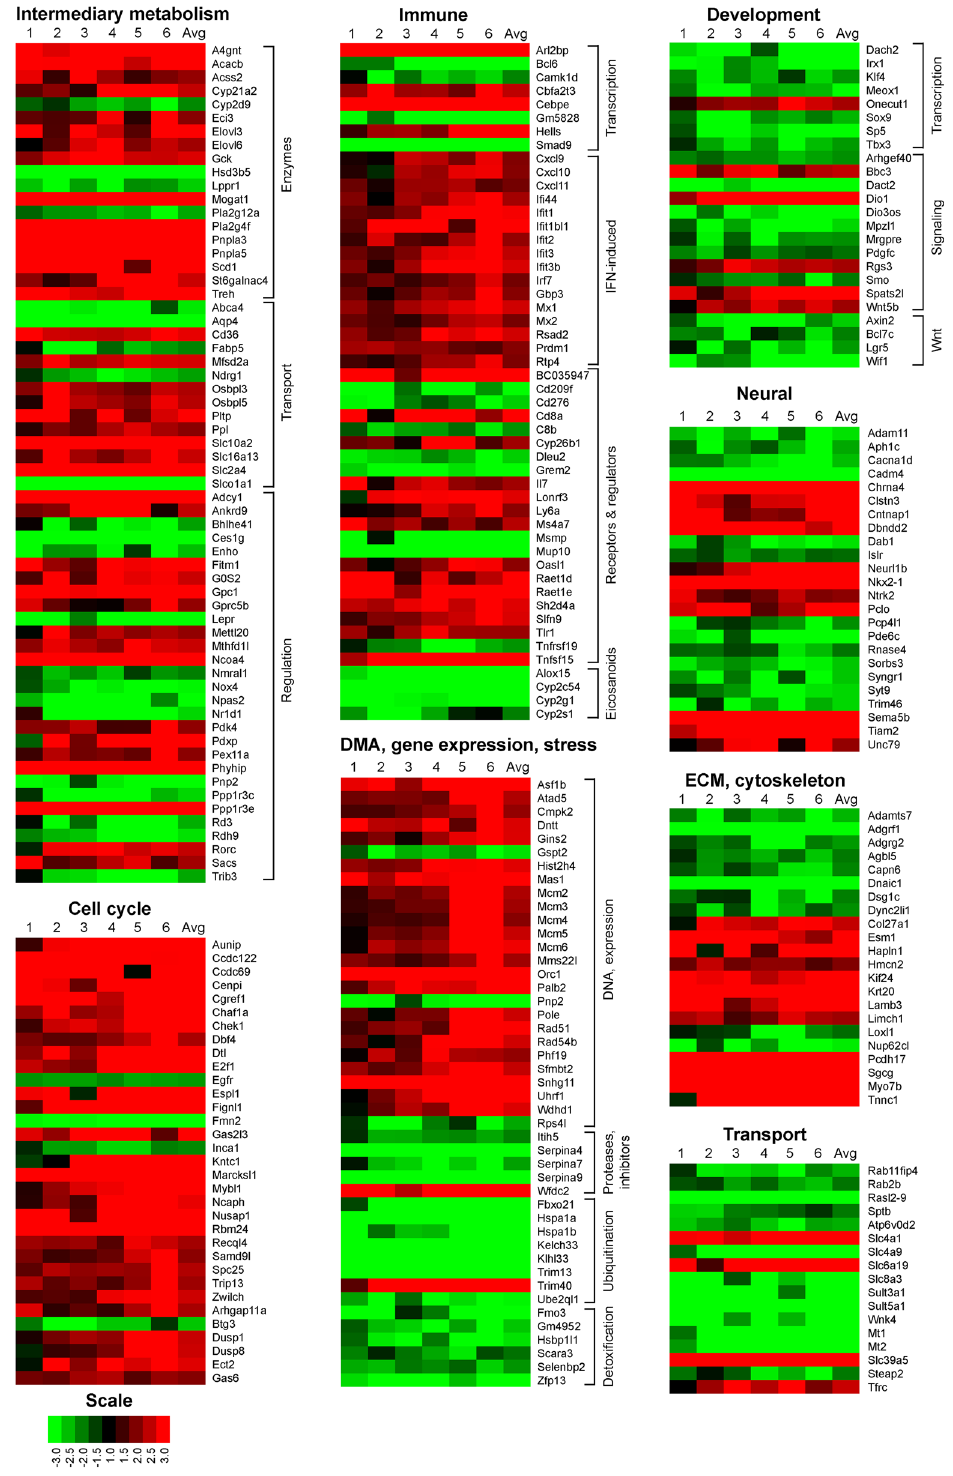
Figure 4. Differential expression of genes for immunity, metabolism, and other cellular functions in the liver of Nod2 − / − mice on HFD. Heatmap representation of the fold increase (red) or decrease (green) for gene expression in the adipose tissue of Nod2 − / − HFD mice compared with WT HFD mice. The genes are grouped based on function or pathway. The fold ratio for individual Nod2 − / − HFD mice to the average of WT HFD mice was computed and is shown (lanes 1 to 6) with the average of the fold for all Nod2 − / − HFD mice. Genes that had a fold change of ≥ 2 or ≤ 0.5 ( ≤− 2) and P ≤ 0.05 with 5% FDR are included in the heatmap. N = 6 mice/ group. The numerical data for fold increase in individual mice, the average, P value, and FDR are shown in Supplementary Table